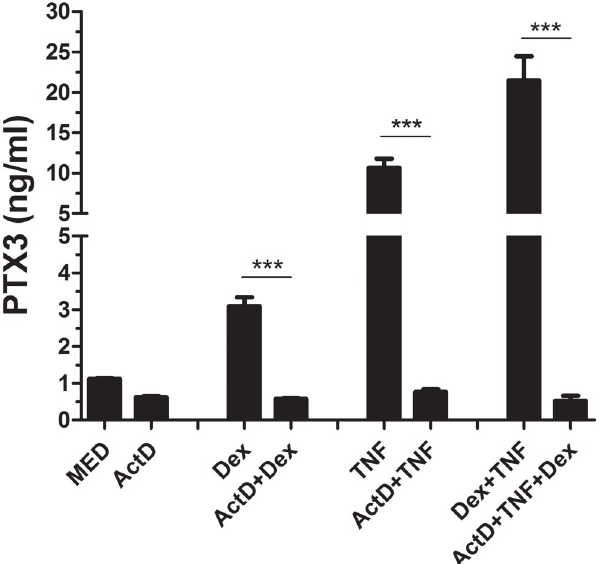
Fig 3. Induction of PTX3 protein release by DEX alone, or in combination with TNF depends on mRNA neosynthesis in HASMC. Serum-deprived HASMC were pre-treated with Act D for 30 min before DEX (10 − 6 M) and TNF (10 ng/ml) were added either alone or in combination for 24 h. Supernatants were then harvested analyzed by ELISA. Results are representative of 3 donors in triplicate ( ��� P < 0.001).